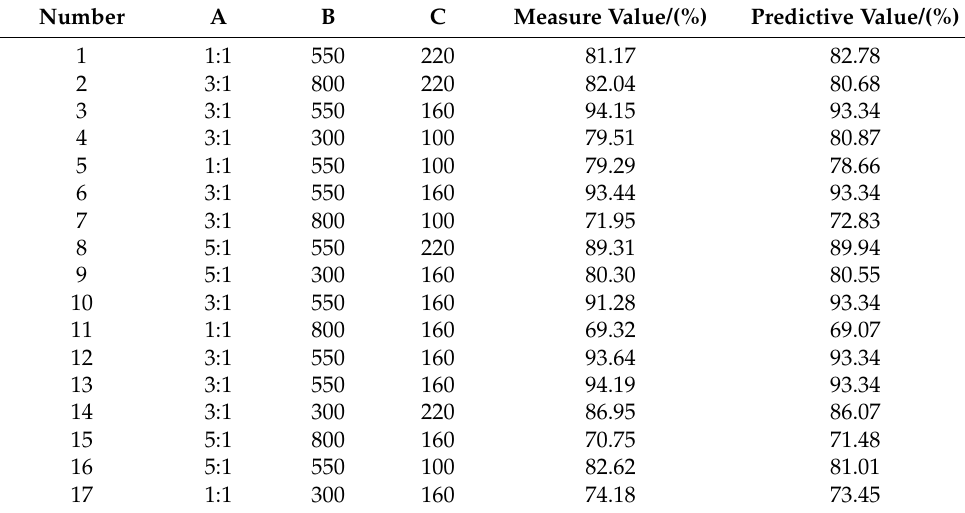
Table 2. Box-Behnken experimental design and response